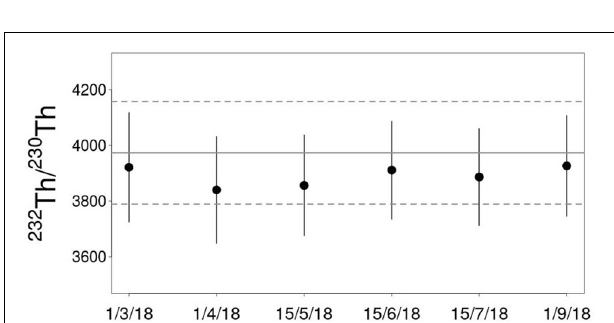
FIGURE 3 | Measured 232 Th/ 230 Th ratios in SW2010-2 reference solution for six separate analyses performed over a 7-month period. Solid gray line represents the average value and the dashed gray lines represent 1 standard deviation of the values reported by participating laboratories of the GEOTRACES intercalibration (Anderson et al., 2012). Error bars on measurements are 1 σ of the instrument